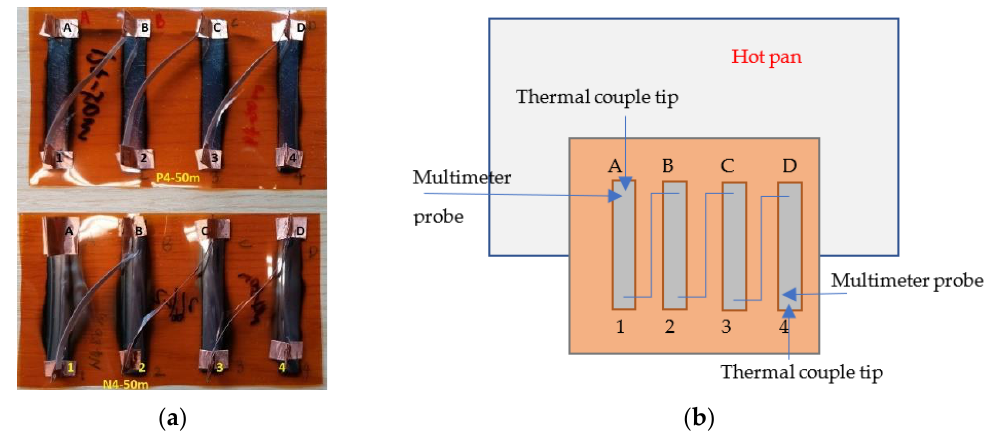
Figure 2. Setup for the measurement of the power output of thin film on Kapton substrate: ( a ) the film strips on Kapton substrate; ( b ) the sketch of the Kapton on a hot pan for test.